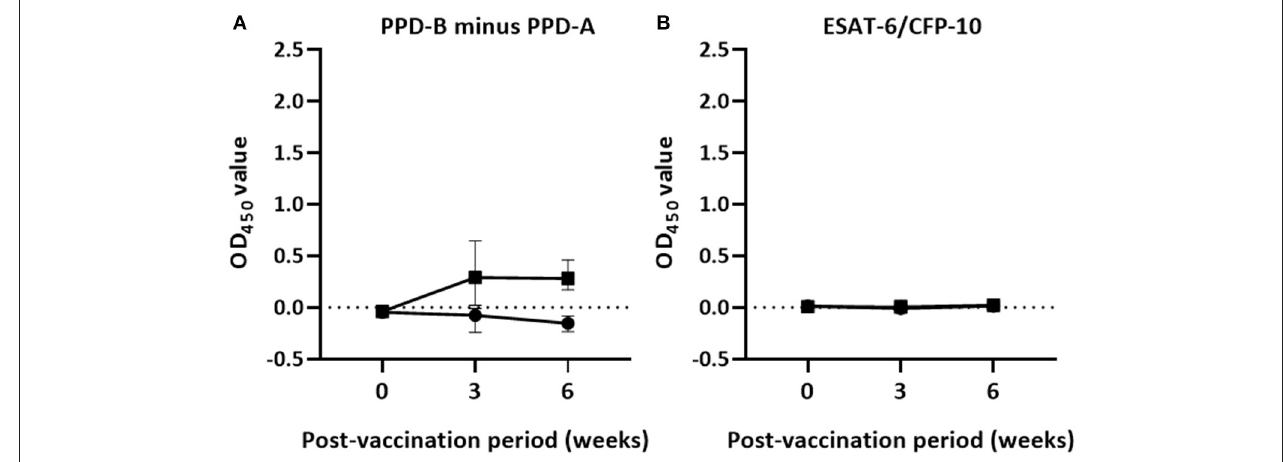
FIGURE 1 | Post-vaccination IFN- γ responses in the experimental calves. The figure describes Antigen-specific IFN- γ production in whole blood cultures of 22 vaccinated and 18 control calves 6 weeks after vaccination. The released IFN- γ was measured from whole blood stimulated with PPDs (A) or specific peptides cocktail (B) using the BOVIGAM assay. There was a statistically significant difference ( p < 0.0001) in IFN- γ responses to PPD (B-A) in vaccinated and control calves at the 3rd and the 6th week while the IFN- γ response to the peptides cocktail was not detectable in both groups of calves after vaccination. Error bars indicate the median ( ± 95% CI) OD 450 value of the two groups for each time point.